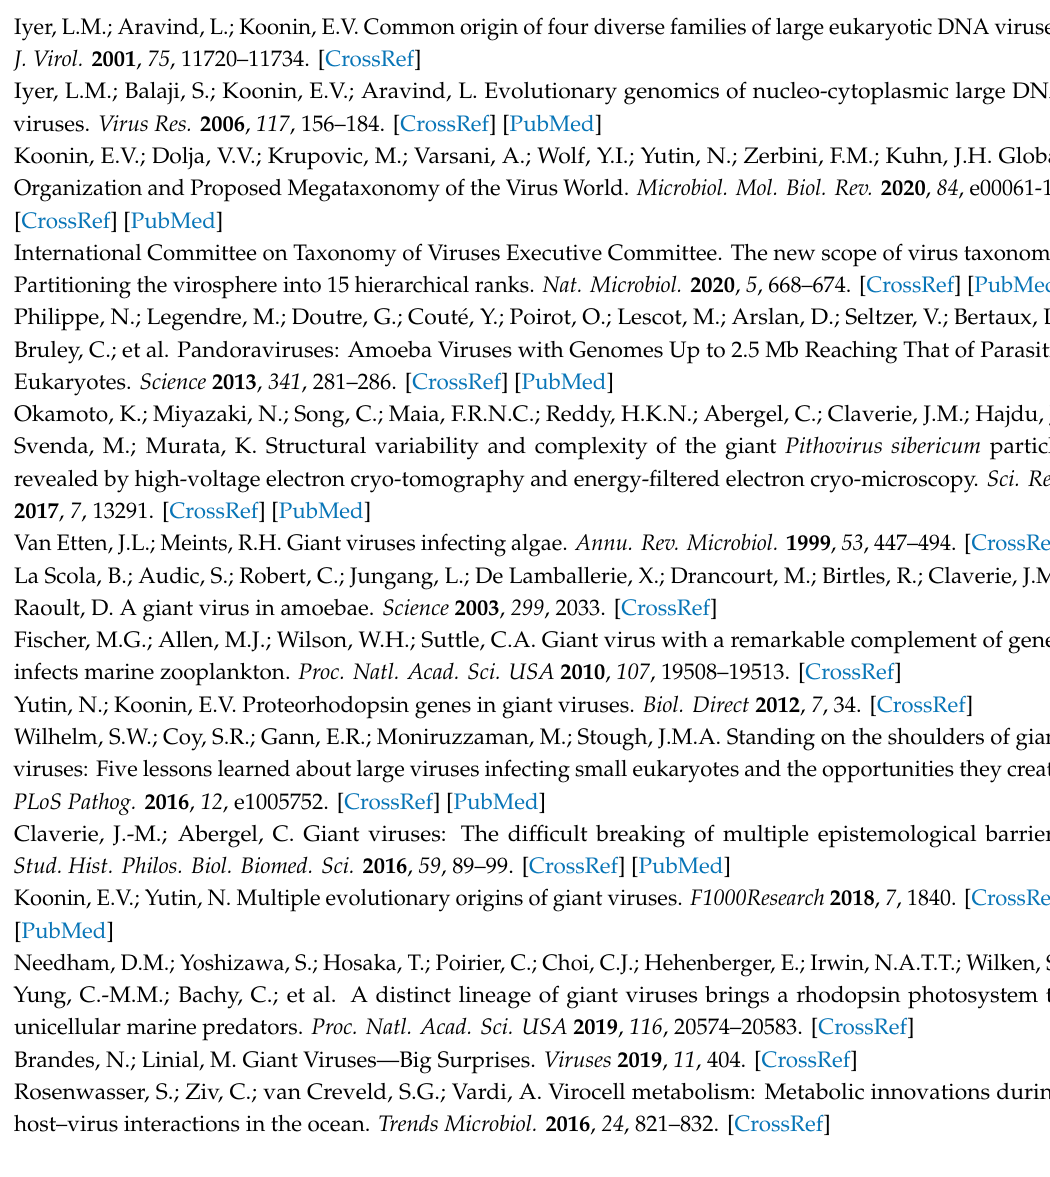
Table S1: Giant virus strains and their phylogenetic placement, genome information, and